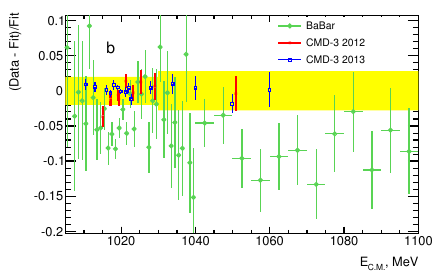
Figure 9. Comparison of the CMD-3 measure- ment of e + e − → K + K − to previous CMD-2 [15] and SND [13] measurements. The width of the band shows the systematic uncertainties in the CMD-3 study.